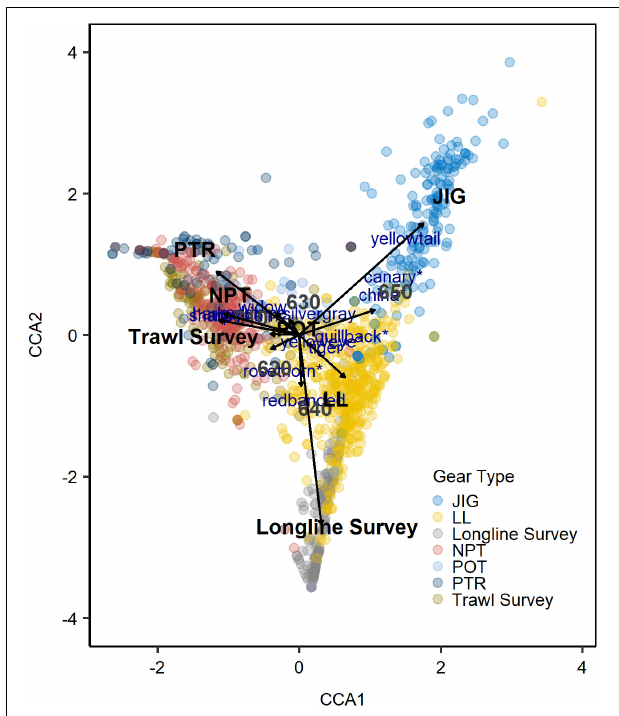
FIGURE 8 | CCA results using the proportions matrix with units (year-month-subarea-gear) plotted on the first two CCA axes. Gear type is color coded, species are marked in blue text (with species currently assigned to the Demersal Shelf Rockfish marked with “*”) and factors (i.e., gear and subarea) provided in black bold text. Gear types include fishing gear (jig [JIG], longline hook and line [LL], non-pelagic trawl [NPT], pot [POT], and pelagic trawl [PTR]) and surveys (longline and trawl